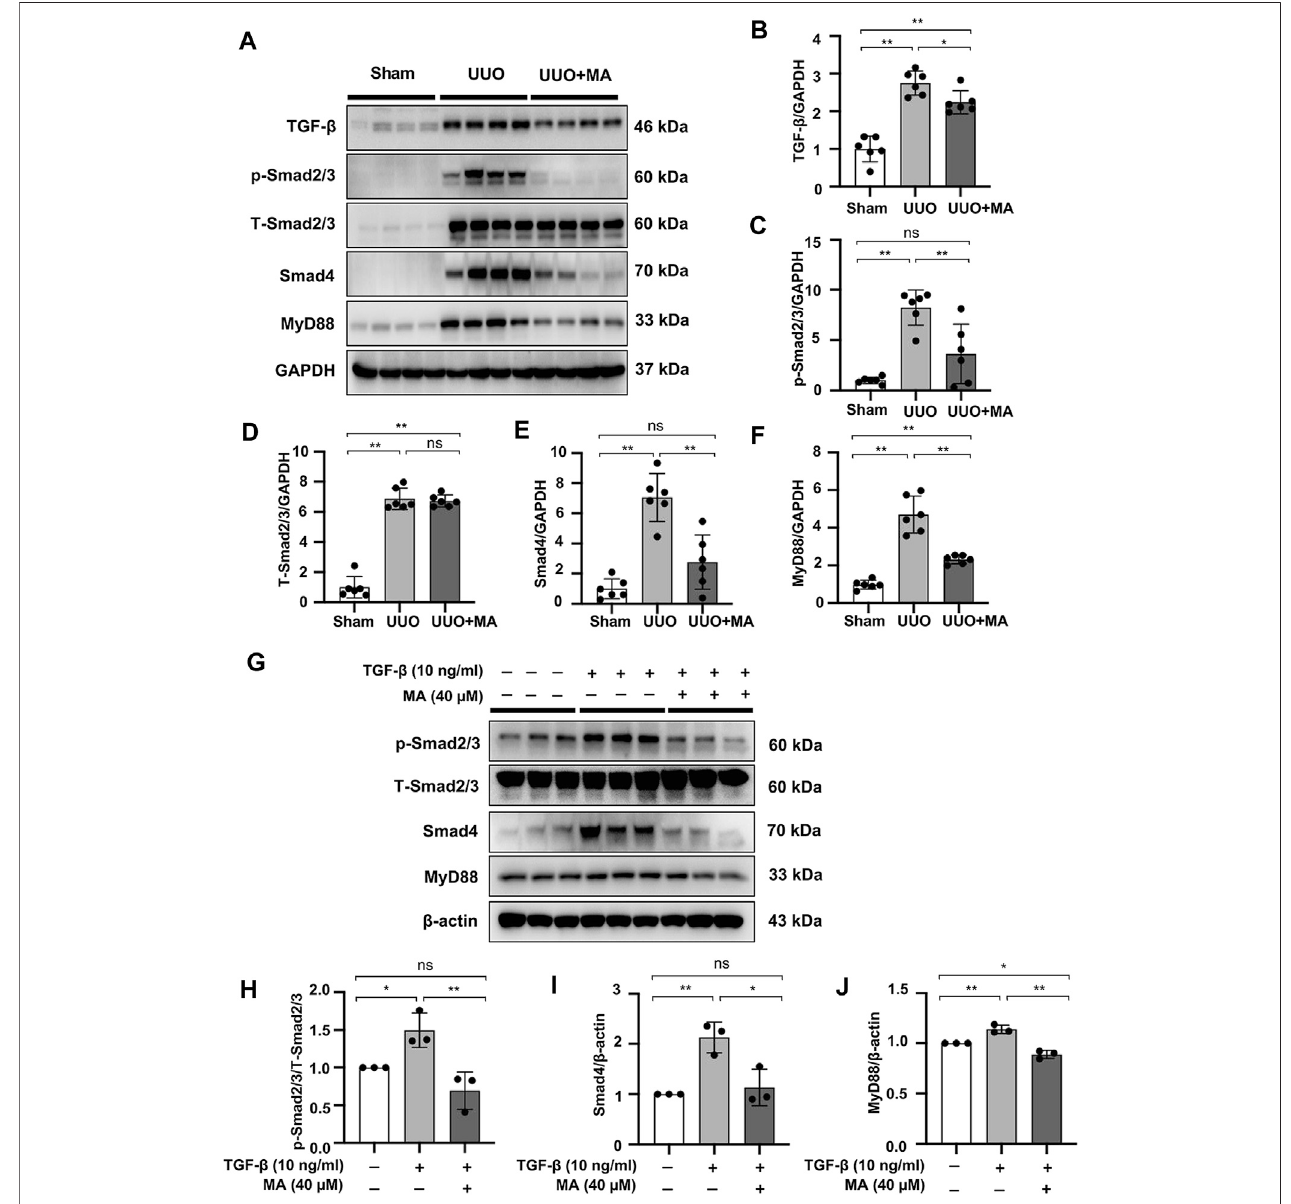
FIGURE4| MAsuppressestheTGF- β /SmadsignalingpathwayanddownregulatesMyD88expressioninUUOmodelandNRK49Fcells. (A) ExpressionofTGF- β , p-Smad2/3, T-Smad2/3, Smad4, and MyD88 in the kidney model was detected by western blot and quanti fi ed by densitometry. (B – F) Statistical signi fi cance was presentedasthemean ± SD, n (cid:1) 6.* p < 0.05,** p < 0.01,ns:nosigni fi cance. (G) Expressionofp-Smad2/3, T-Smad2/3, Smad4,andMyD88inTGF- β -treatedNRK49F cells was detected by western blot and quanti fi ed by densitometry. Cells were pretreated with MA for 2 h after starvation with 0.5% FBS medium and then treated withTGF- β (10 ng/ml)for30 min (H – J) Statisticalsigni fi cancewaspresentedasthemean ± SD, n (cid:1) 3.* p < 0.05,** p < 0.01,ns:nosigni fi cance.MA,maslinicacid;UUO, unilateral ureteral obstruction; RT-PCR, Real-Time PCR.